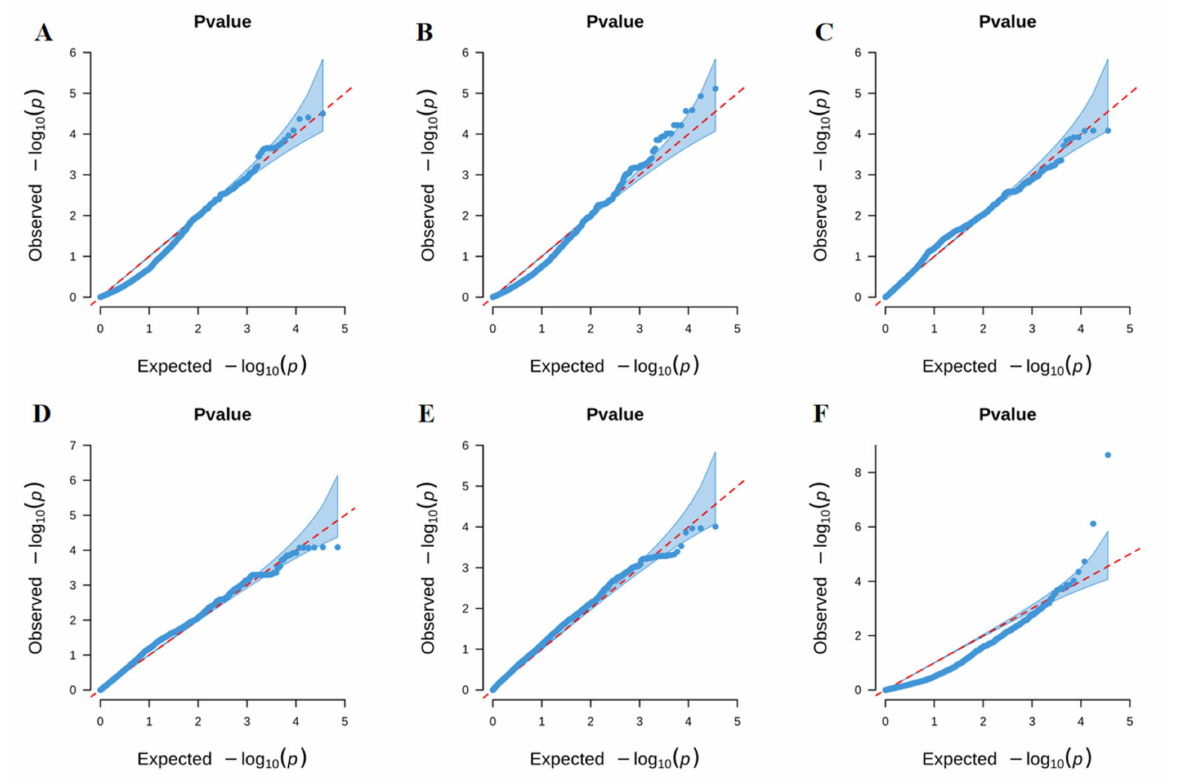
Figure 4. Quantile–quantile (Q–Q) plot of GWAS for six LTG indices (LTGP ( A ), RGP ( B ), RPL ( C ), PLR ( D ), PLRR ( E ), RAPL ( F )).